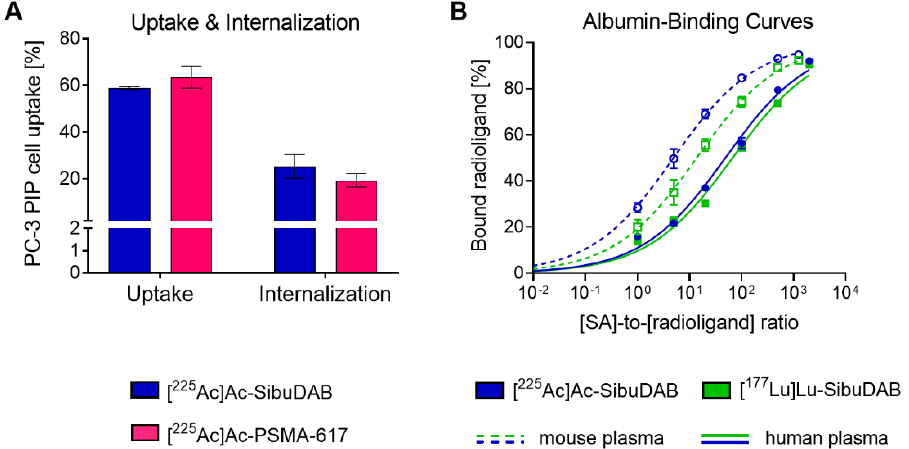
Figure 2. ( A ) Cell uptake and internalization of the 225 Ac-labeled PSMA ligands into PSMA-positive PC-3 PIP cells (average ± SD, n = 3–4). ( B ) Comparison of albumin-binding curves of [ 225 Ac]Ac- SibuDAB and [ 177 Lu]Lu-SibuDAB determined in mouse and human blood plasma. The blood plasma was diluted to obtain a series of different molar concentration ratios of serum albumin (SA) to radioligand.